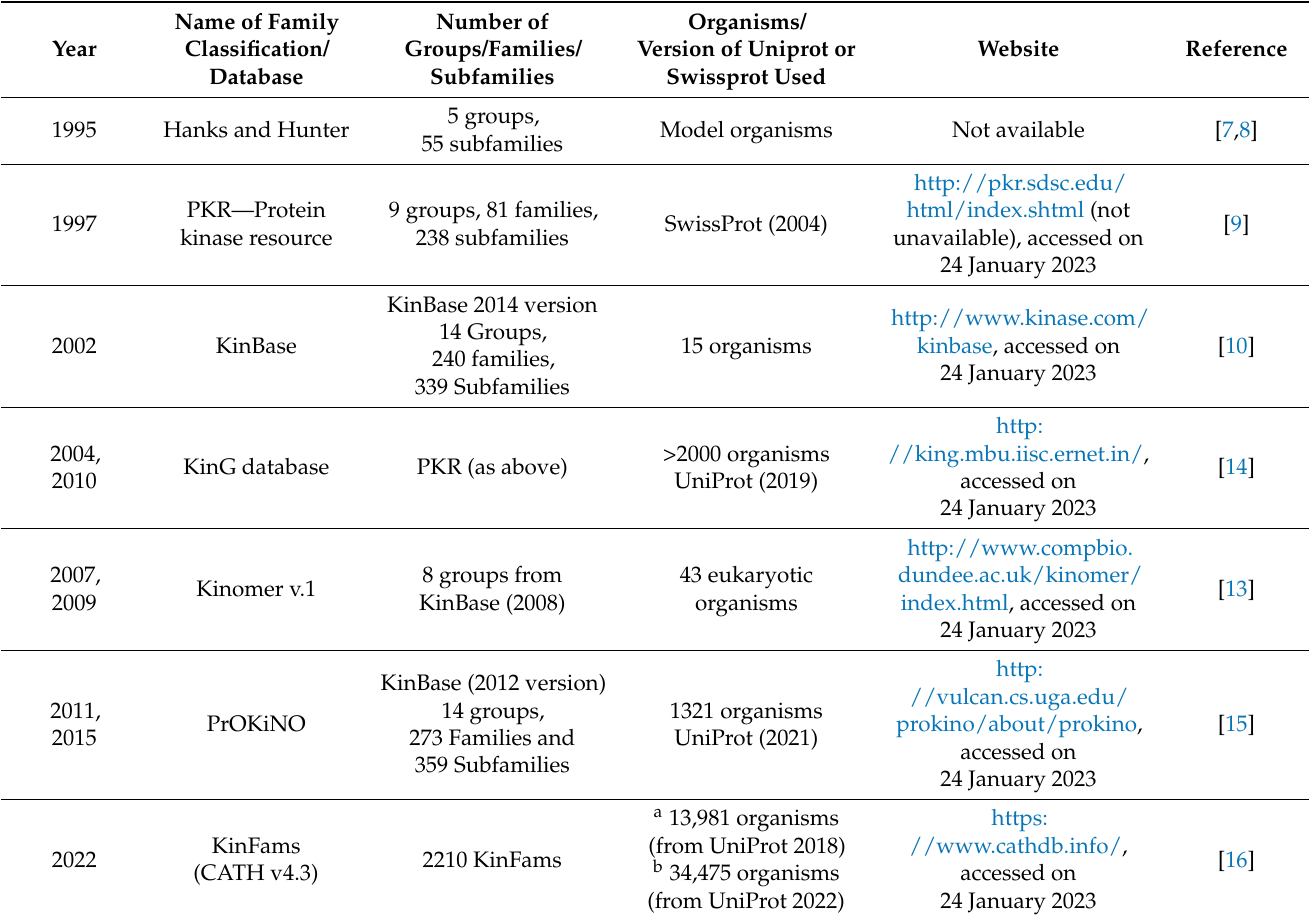
Table 1. The summary of existing kinase classification schemes and associated resources. Hanks and Hunter (1995) developed the first kinase classification scheme, which was expanded in 1997 by the Bourne group (Protein Kinase Resource) and Manning group (KinBase). KinBase (version 2014, shown in bold). Other groups subsequently applied these classification schemes to map sequences from other additional species. For example, KinG has mapped sequences from over 200 organisms to families in Protein Kinase Resource (PKR). PrOKiNO has mapped kinase sequences from 1321 species to families from KinBase (2012). More recently, CATH-KinFams, described in this study, maps sequences from 13,981 species to 2210 functional families, using the novel FunFam-MARC protocol. a KinFams consist of alignments of kinase domain sequences from 13,981 species (UniProt release 2018_02). b Using HMMs built from these KinFams a , we detected hits to an additional 20,494 organisms (total 34,475) from the latest UniProt release